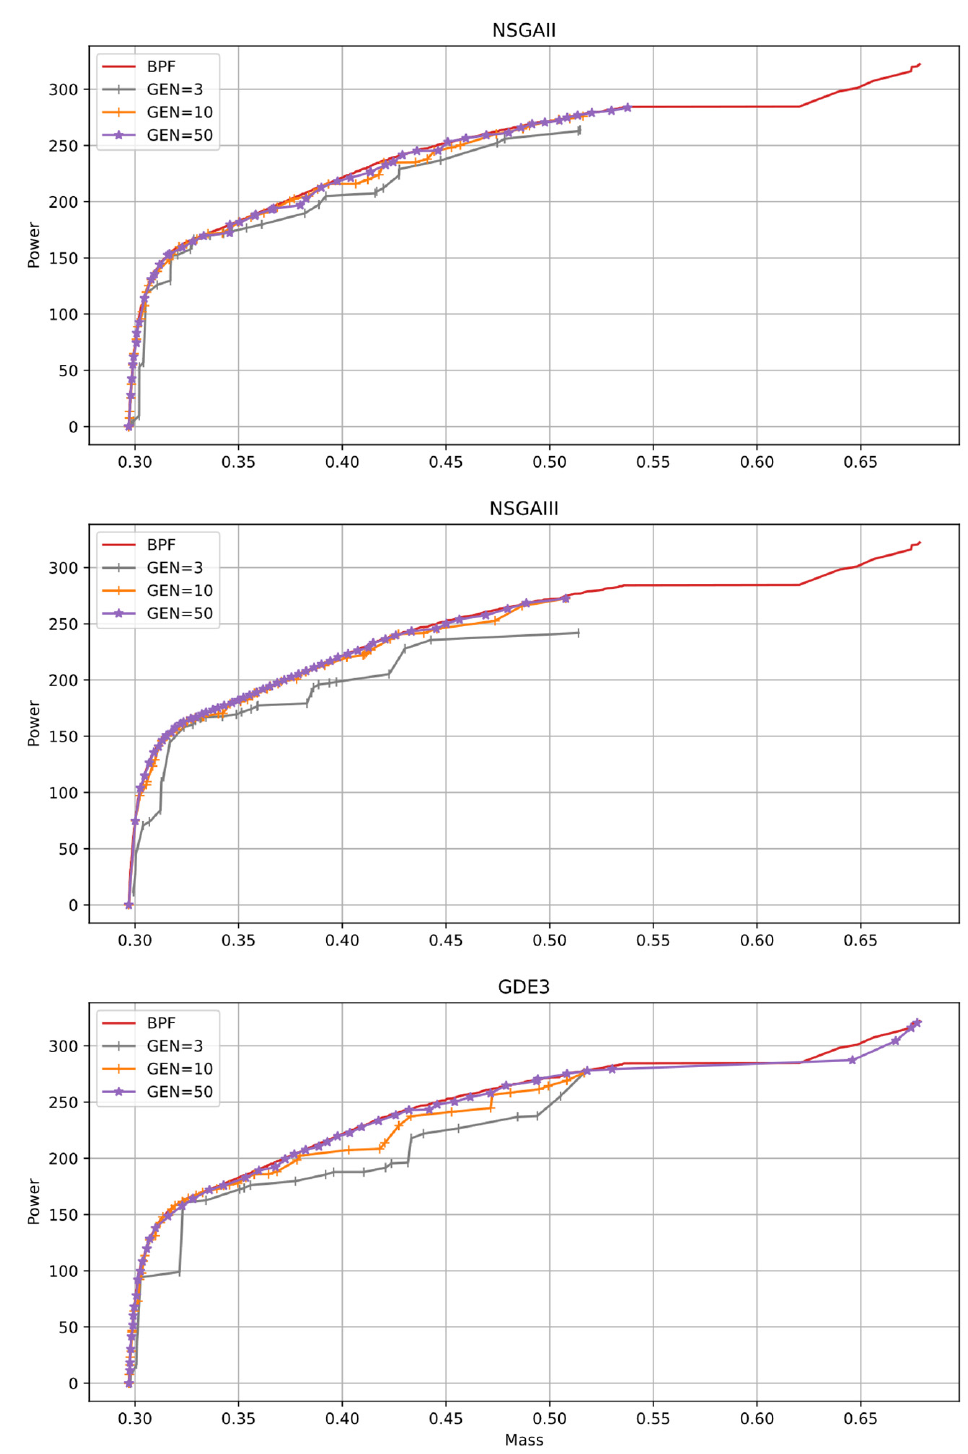
Figure 5. NSGA-II, NSGA-III, GDE3 Pareto front evolution through generations.